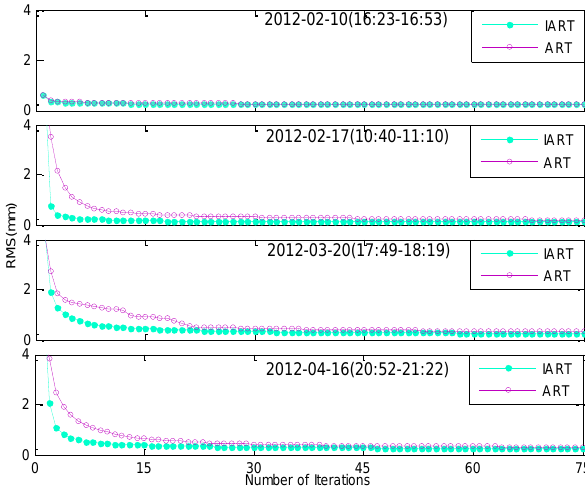
Fig. 6. Vertical profiles of tomographic water vapor at four different longitudes on March 20, 2012.